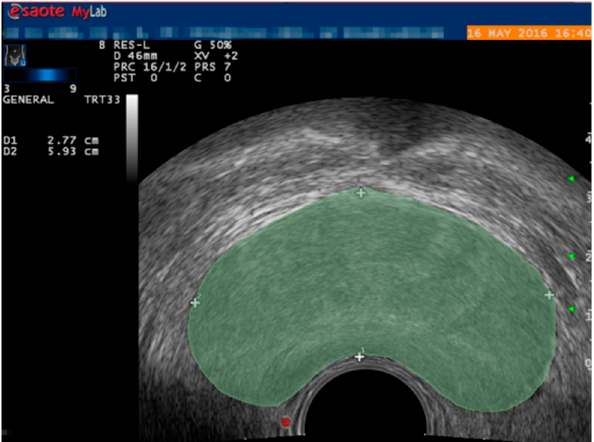
Figure 2. TRUS image of the prostate.